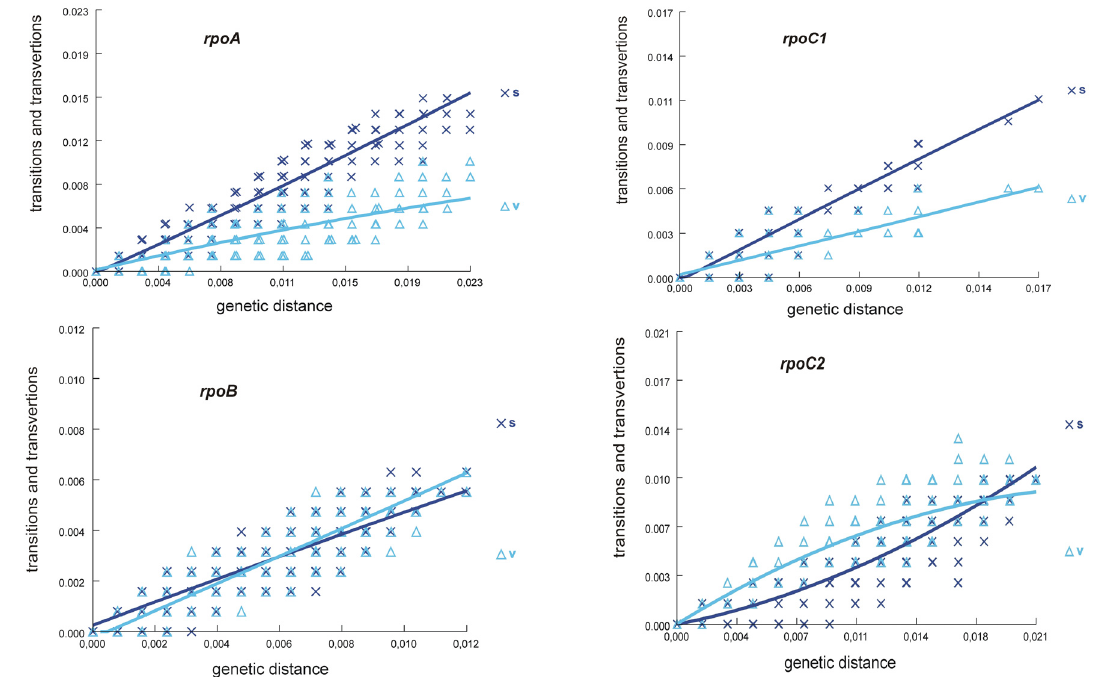
Figure 3. Transitions and transversions versus divergence plots (s — transitions, v — transvertions; lines show the general trend). The estimated number of transitions and transversions for each pairwise comparison was plotted against the genetic distance. This pattern can be interpreted as indicating that substitution saturation has not been reached, so that the data can be expected to provide reliable phylogenetic